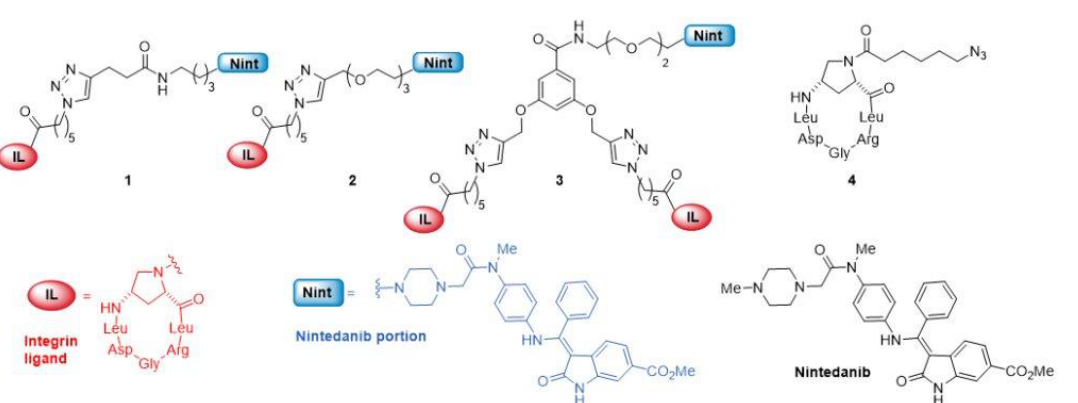
Figure 1. The three-integrin ligand (IL)-nintedanib (Nint) conjugates 1 – 3 of this work. The IL is a previously reported cyclic peptidomimetic [ c (AmpLRGDL)] incorporating the integrin-recognizing sequence RGD and the cis -4-amino-L-proline residue (Amp). Unconjugated ligand 4 and nintedanib were used as reference compounds in the biological assays.